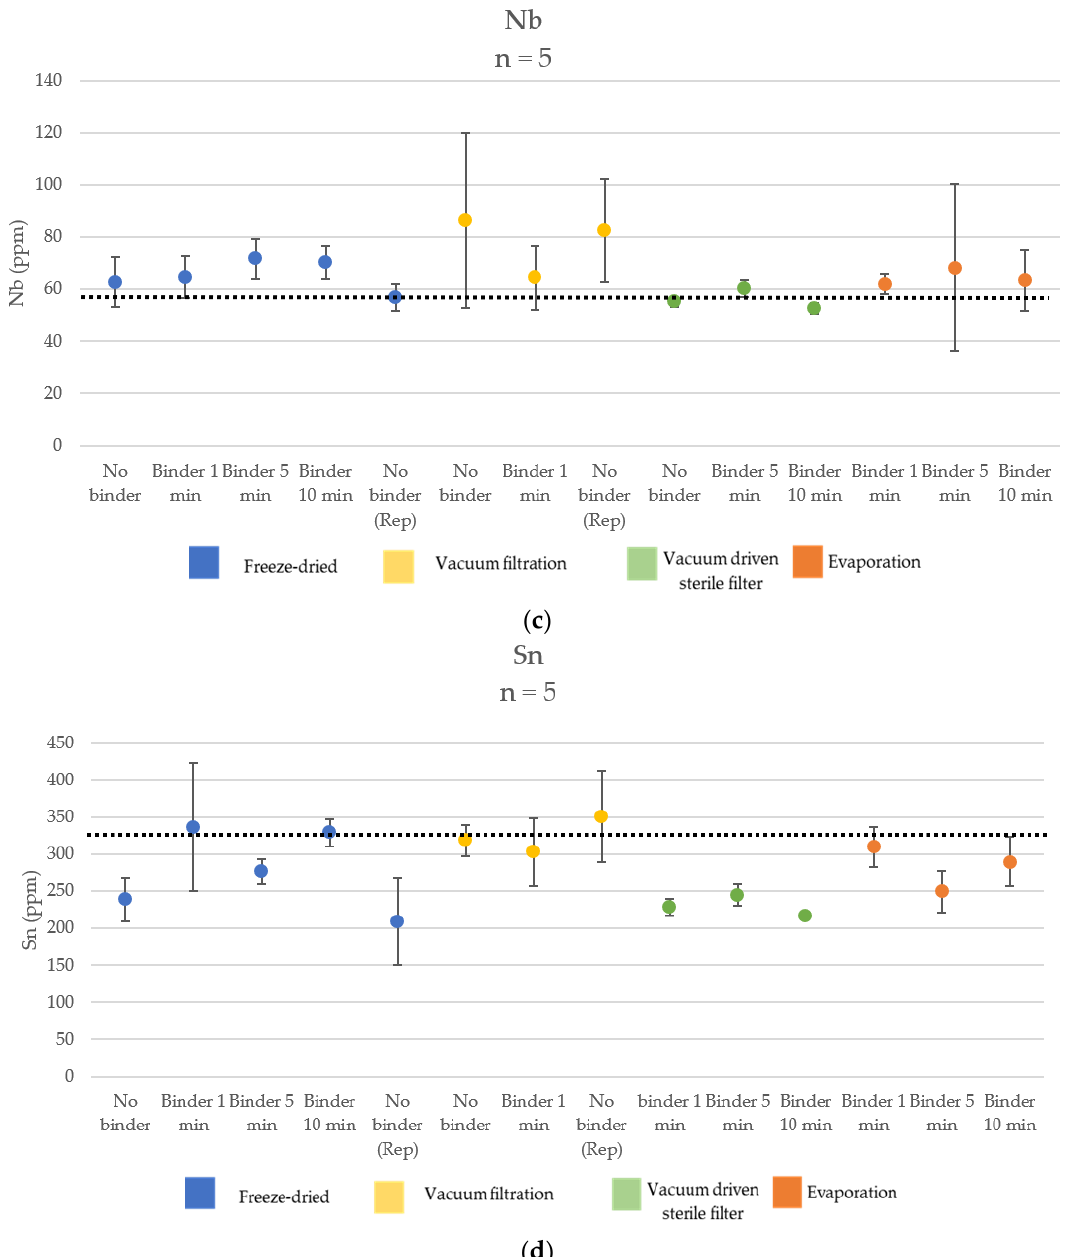
Figure 4. Summary of the element content of the Penouta and Mittersill ore pellets after LA-ICP-MS using different drying techniques in ppm. ( a ) Data for tungsten (W) in Mittersil ore, ( b ) data for tantalum (Ta) in Penouta ore, ( c ) data for niobium (Nb) in Penouta ore, and ( d ) data for tin (Sn) in Penouta ore. Table 3. Summary of W concentrations (ppm) of the Mittersil ore pellets obtained by LA-ICP-MS spot analysis following pellet production using different drying techniques. The values are based on data normalized to SiO 2 as an internal standard. SD = standard deviation; rep = repeated analyt- ical run.